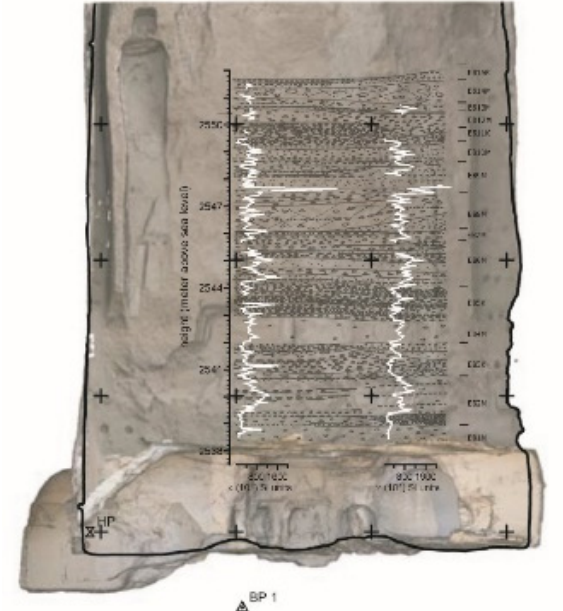
Figure 9. Geological Mapping of the rear side of the 38m Eastern Buddha niche (Urbat